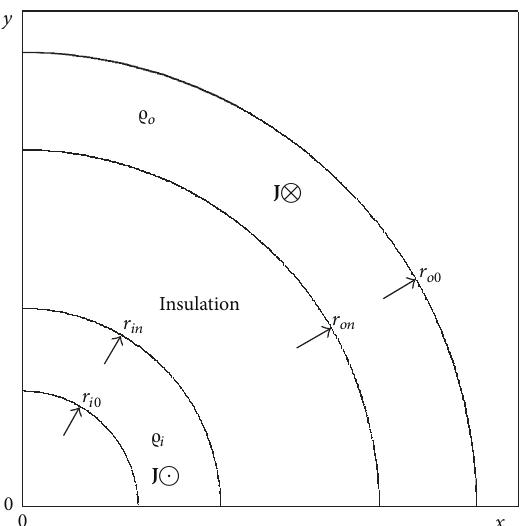
Figure 1: A quarter of the cross section of coaxial conductors and of the insulation between the